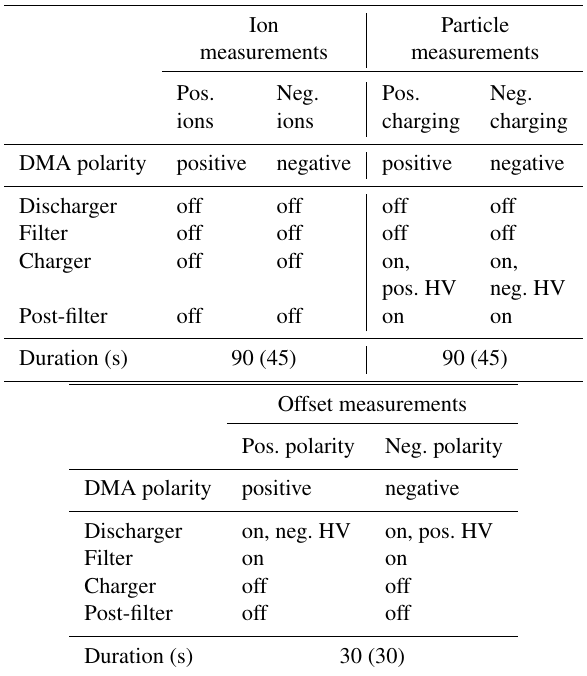
Table 1. Recommended measurement modes and measurement cy- cle of the